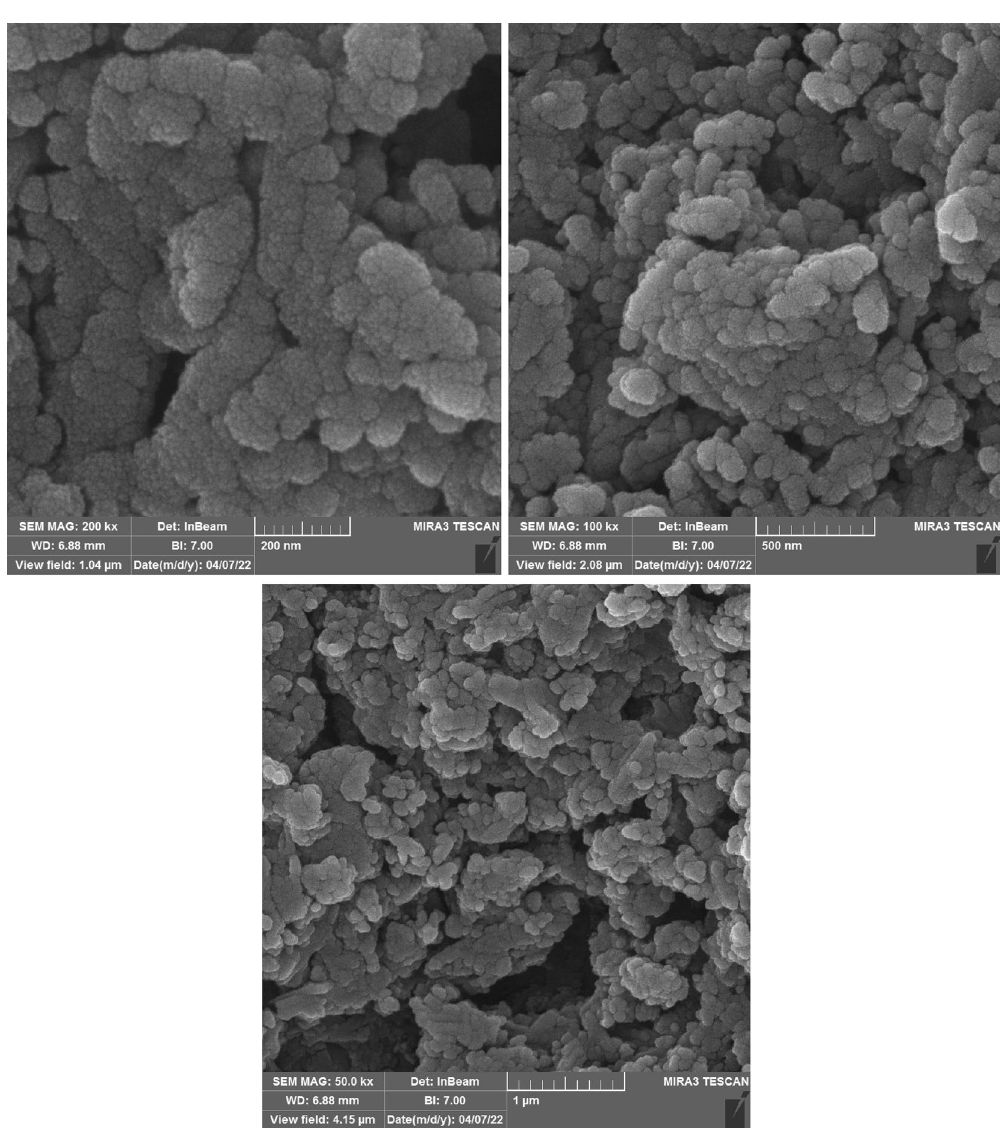
Figure 10. SEM images of Cu(II)-MP-bis(AMP)@boehmite after